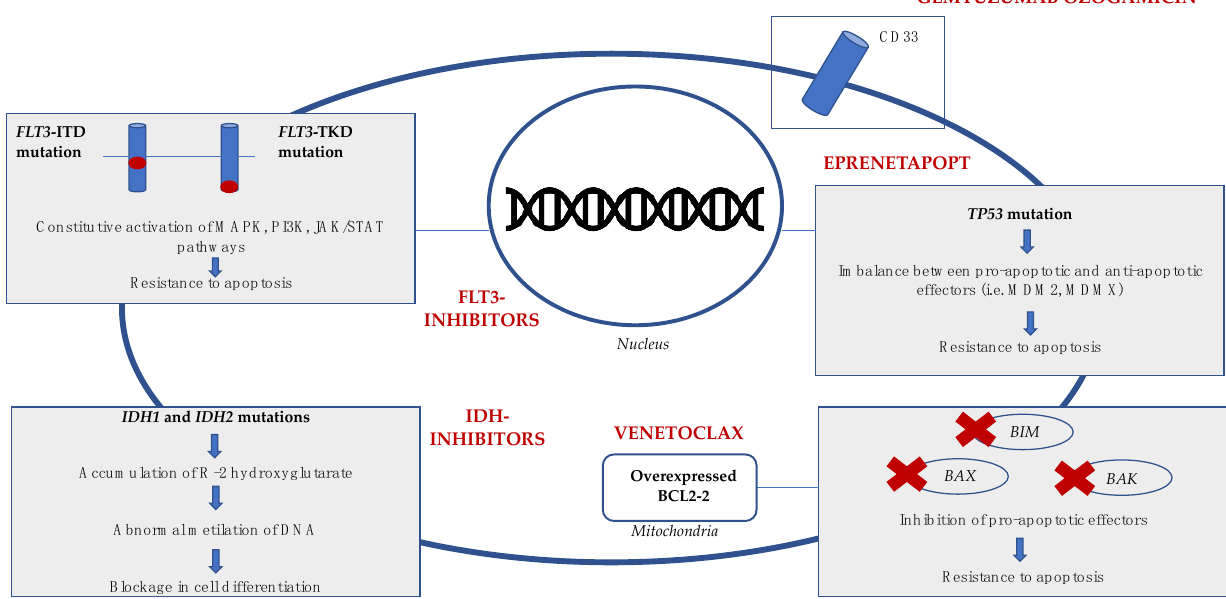
Figure 1. Selected cellular pathways targeted by new AML drugs.